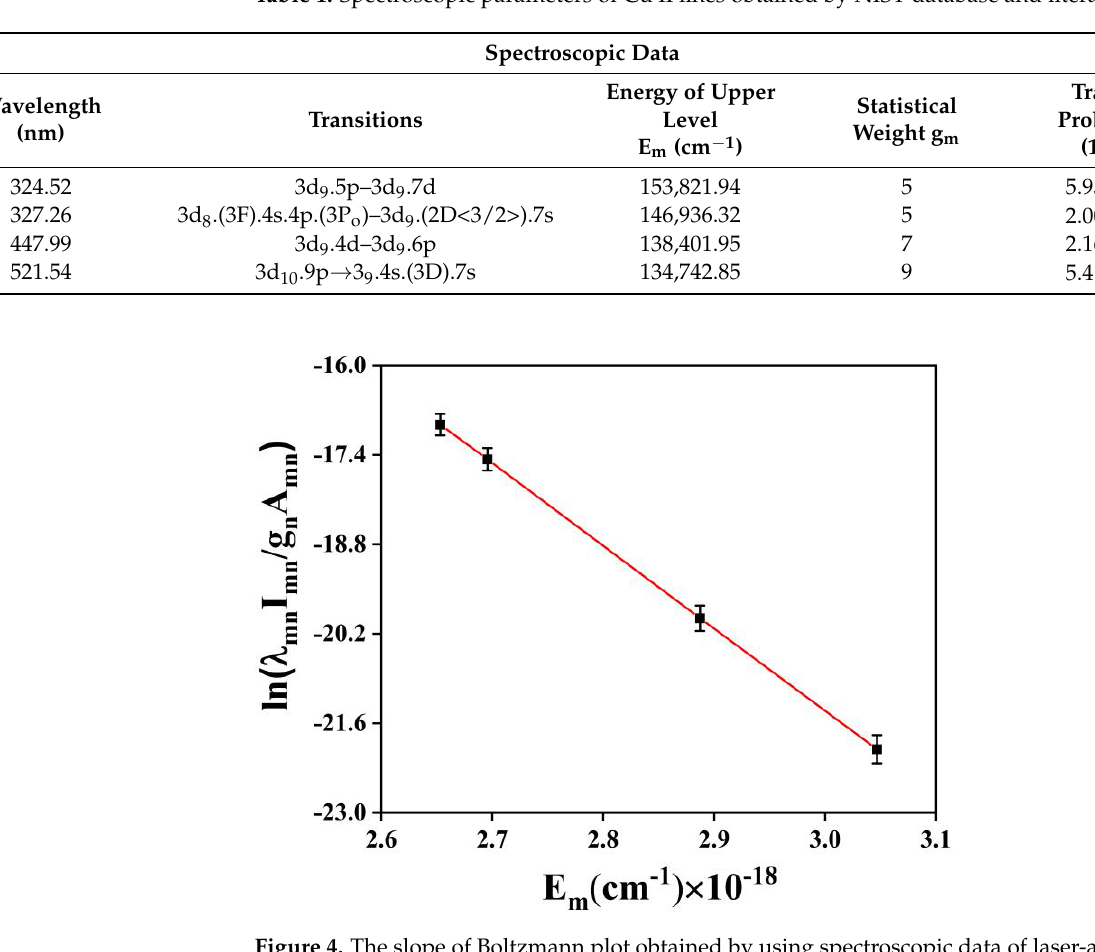
Table 1. Spectroscopic parameters of Cu II lines obtained by NIST database and literature [57,58] .